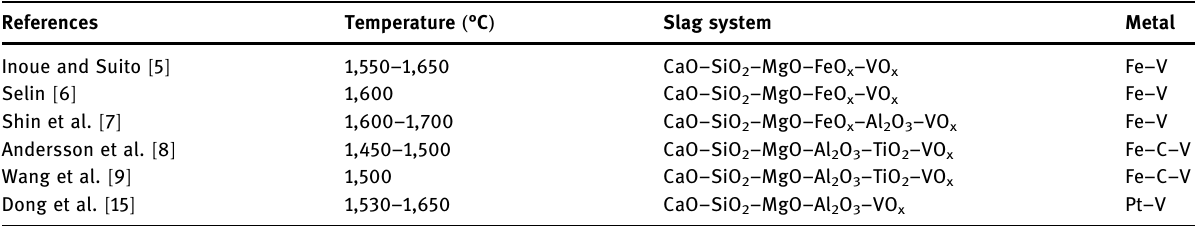
Table 1: Summary of the published studies of the multi - component V - containing slags